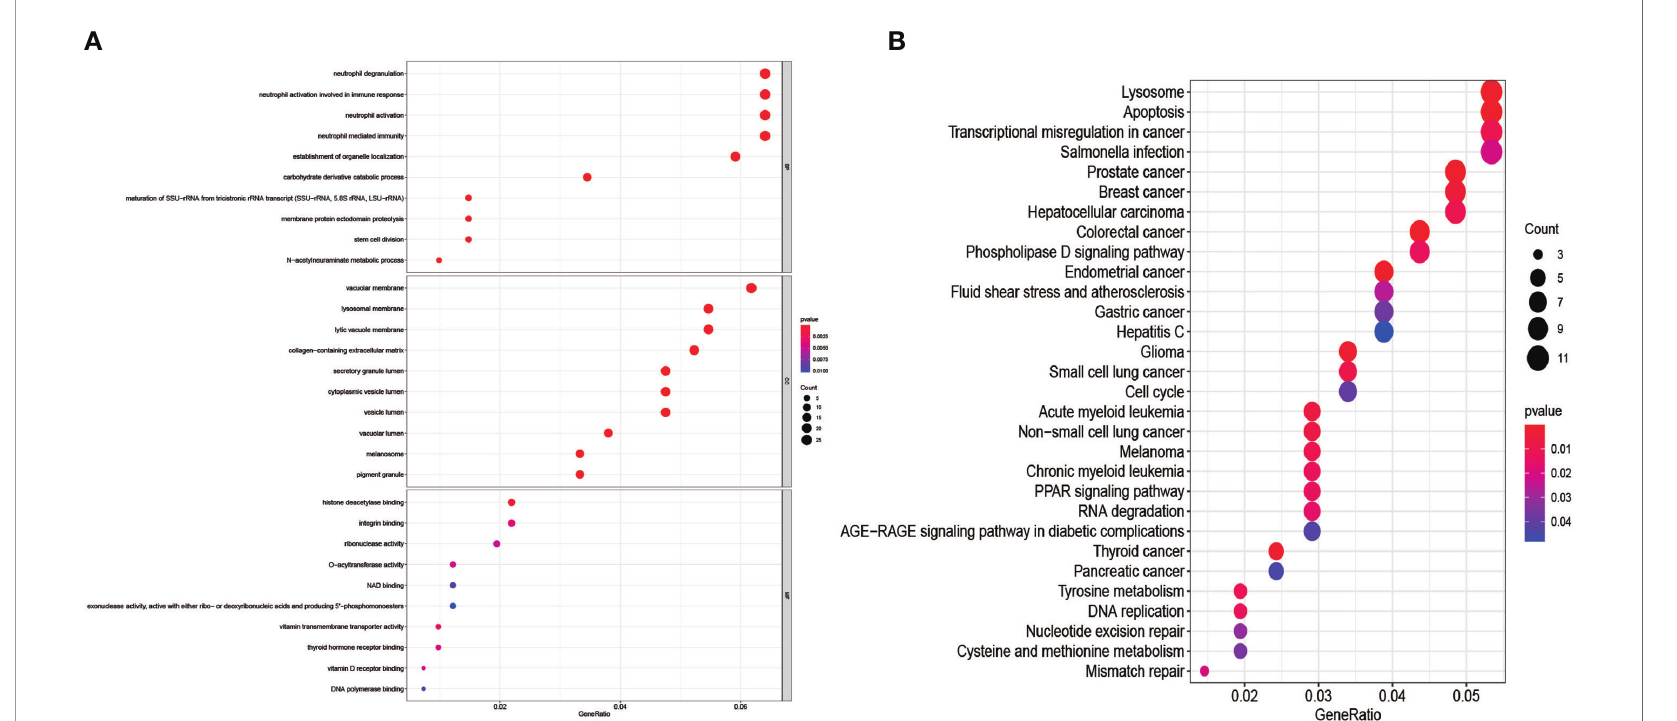
FIGURE 6 | GO enrichment analysis and KEGG pathway enrichment analysis of DEGs. (A) shows the GO enrichment analysis of DEGs; (B) shows the DEGs ’ KEGG pathway enrichment